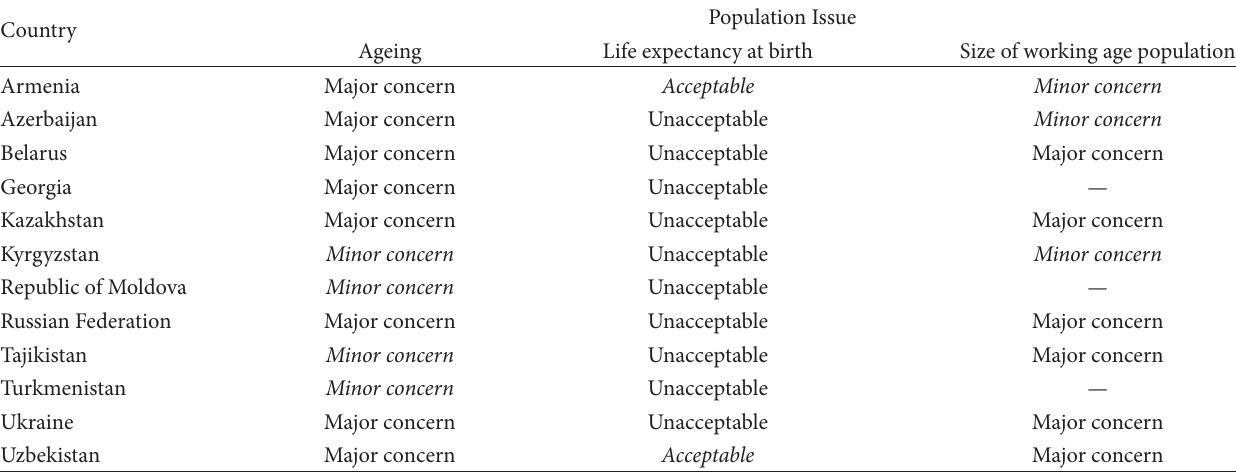
T 3: Views of the CIS governments on selected population issues,